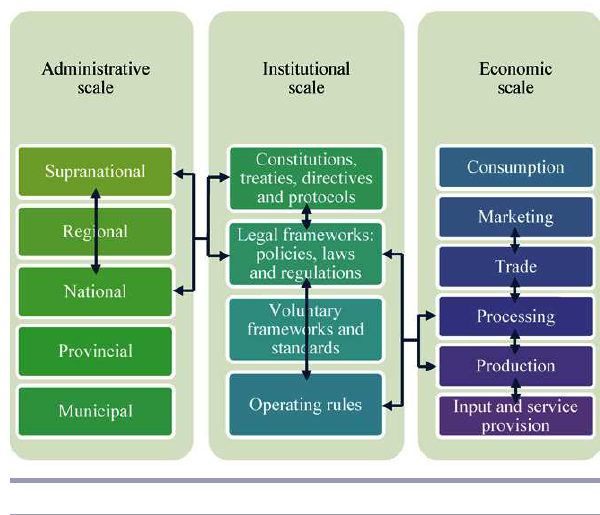
Fig. 5. Schematic representation of scale dynamics analysis: Step 3, Phase II.